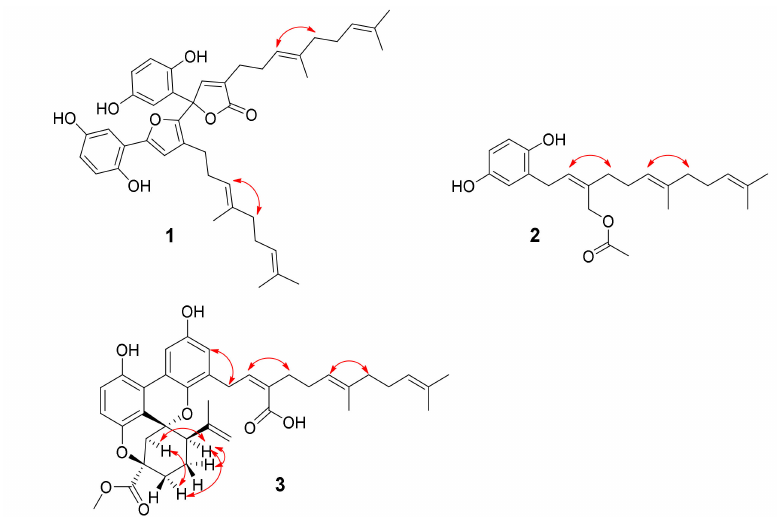
Figure 3. Key ROESY correlations for 1 – 3